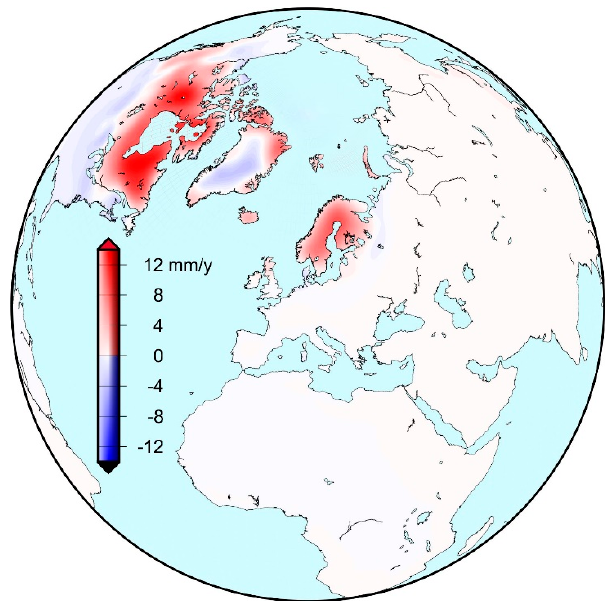
Figure 2. The present-day vertical uplift (in mm / yr) predicted by the ICE-6G GIA model plotted for the northern hemisphere. This uplift is used to construct a hinge line, i.e., a line where the vertical velocities change their signs from positive into negative.